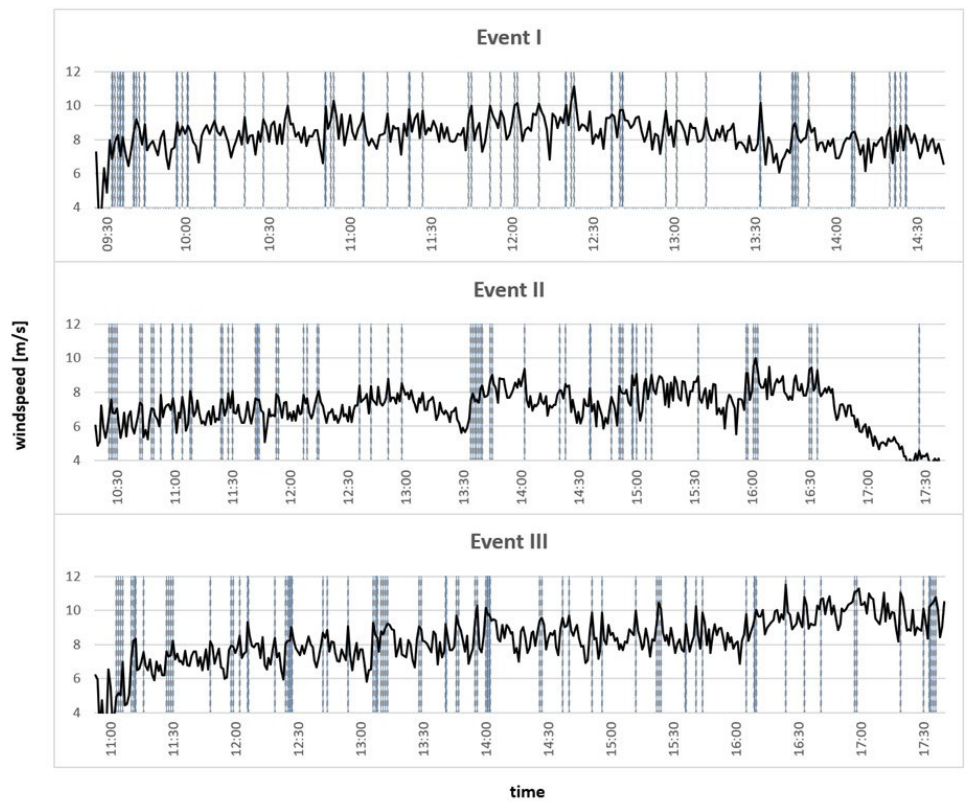
Figure 6. Wind speed during all three events. Grey bulks mark wind gusts following the gust definition described above.